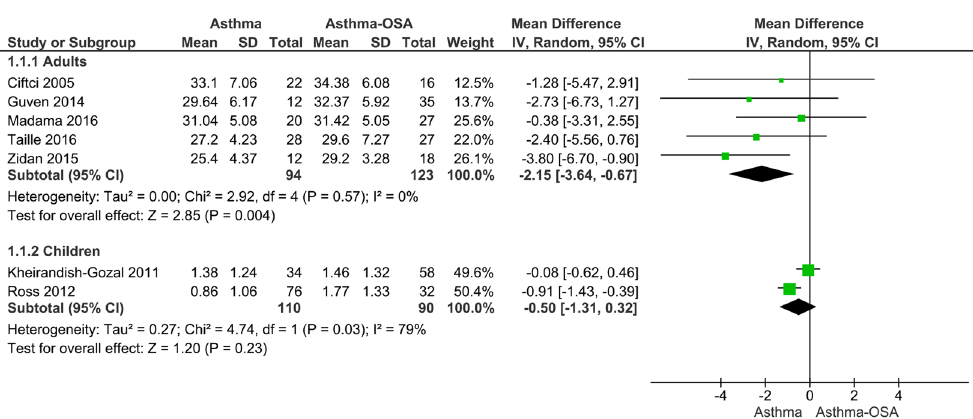
Figure 4. Forest graph showing the mean difference between asthma patients with OSA and without OSA in body mass index of adult and z scores of BMI in